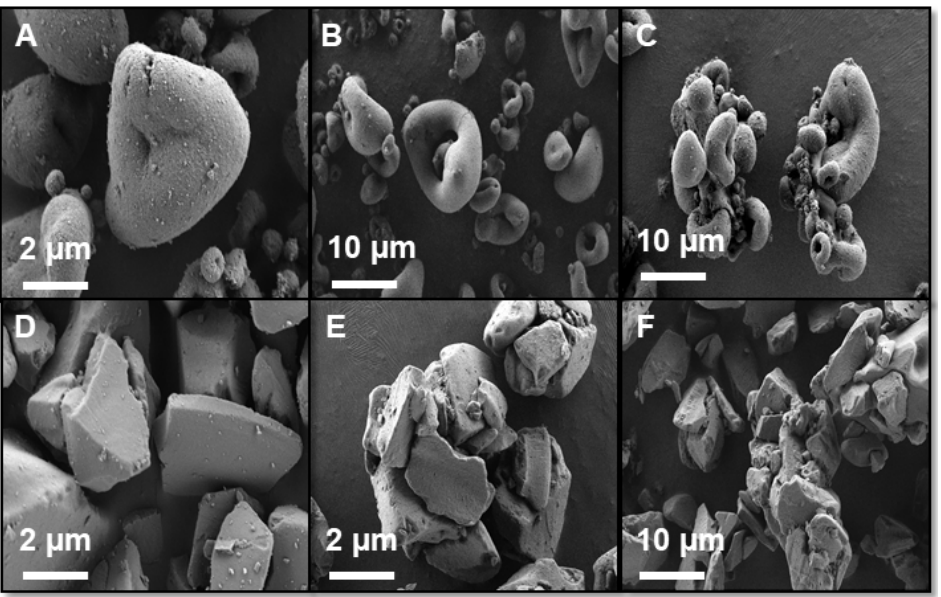
Figure 3. SEM images of ( A ) blank FS, ( B ) 80% FS PG8, ( C ) 200% FS PG8, ( D ) blank MPS, ( E ) 80% MPS PG8, and ( F ) 200% MPS PG8.